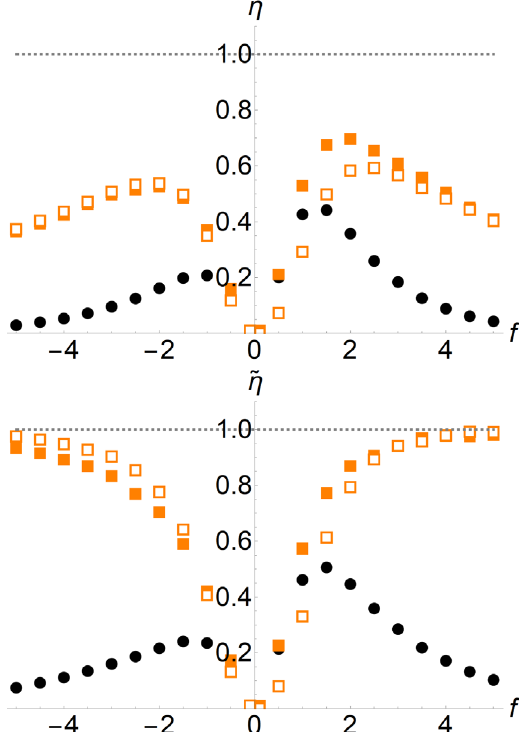
FIG. 3. The ratios η [Eq. (51)] and ˜ η [Eq. (52)] for the two-cycle model as a function of the bias in the left cycle. The filled black circles correspond to the TUR bound η J and the filled orange squares to the CTUR bound η J;Z , in both cases for a flat energy landscape E i ≡ 1 , β ¼ 1 , and f 0 ¼ 1 . The empty orange squares are the results for a random energy landscape, where E i for each site is randomly chosen between 0 and 3. All data are obtained from Monte Carlo simulations using the rates in Eq. (50).